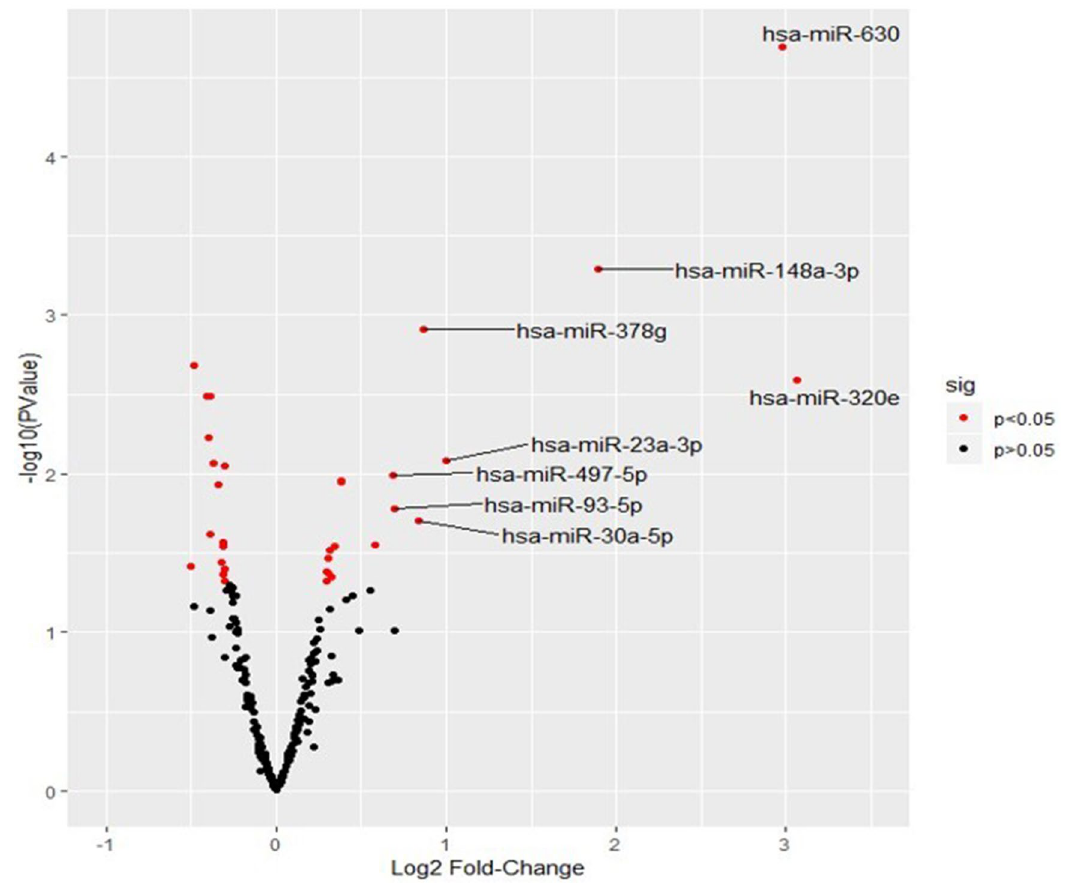
Figure 3. Differential expression of human milk exosome miRNAs in HIV-1 infected women. The differential expression profile of human milk exosomal miRNAs is shown as a volcano plot which demonstrates fold change versus significance ( P < 0.05) to exhibit differences in the miRNA expression between HIV-1 infected and uninfected control women. The X-axis of the plot shows log-base two-fold change whereas Y-axis shows the log P -value. Red color indicates the level of significance ( P <